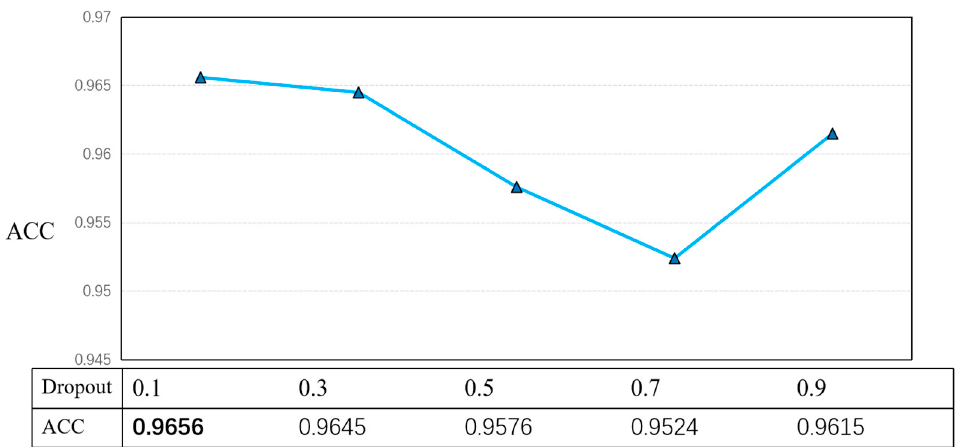
Figure 13. Test relationship between dropout and accuracy when GCN-layer = 2 and m = 0.2. The best result was tested for dropout = 0.1, leading by 0.11. The bolded font in the figure is the optimal effect.